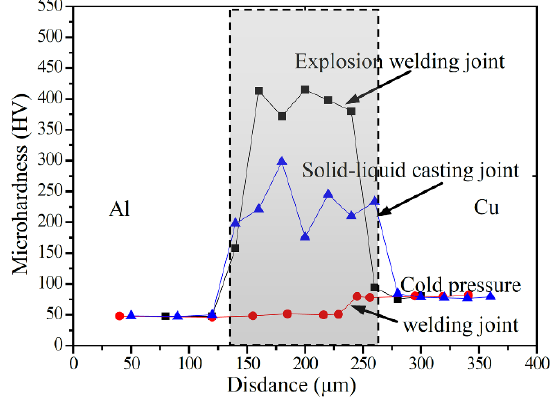
Figure 7. The microhardness distribution across different interface structures.